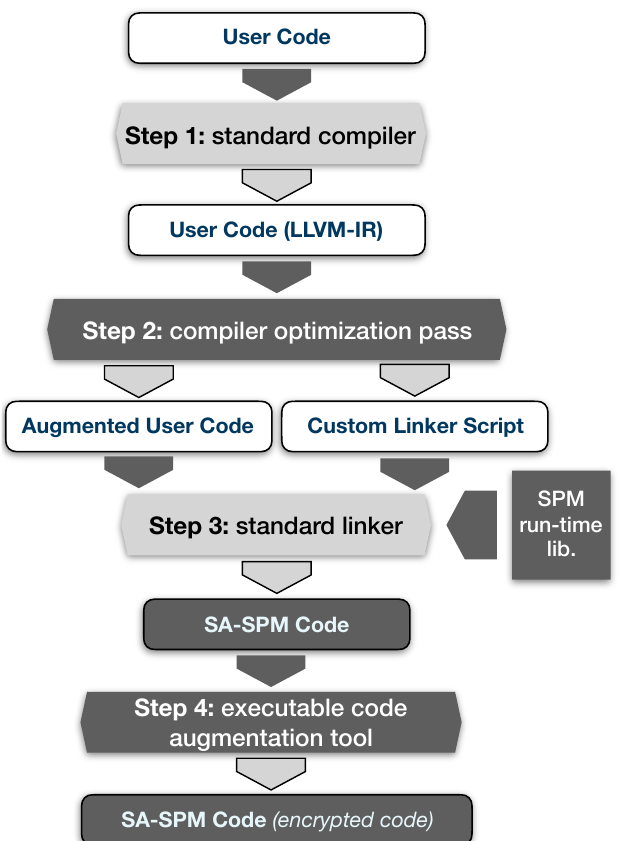
Figure 9. Overall security-aware scratch pad memory (SA-SPM) application generation steps.